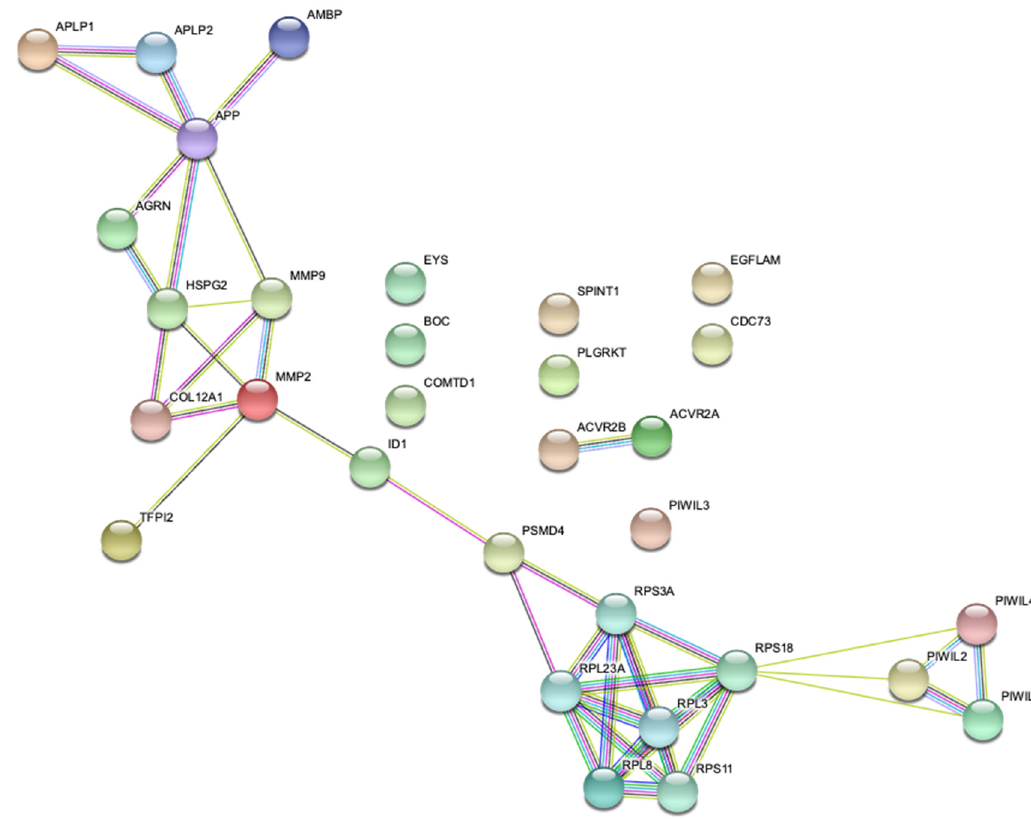
Figure 4. COL12A1 possible gene–gene interactions.